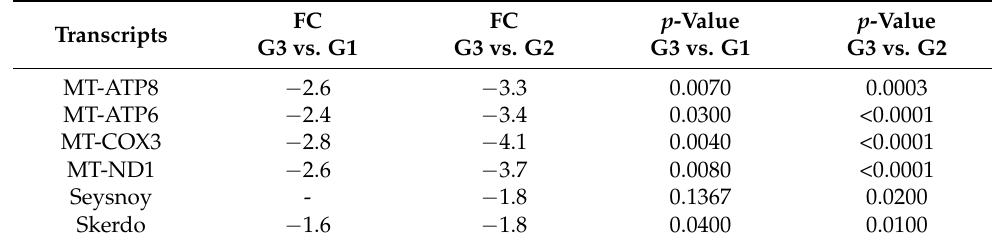
Table 2. p -values and fold-change expression values of selected transcripts analyzed through Real- Time PCR in the validation cohort in G3 versus G2 or G1 comparisons.